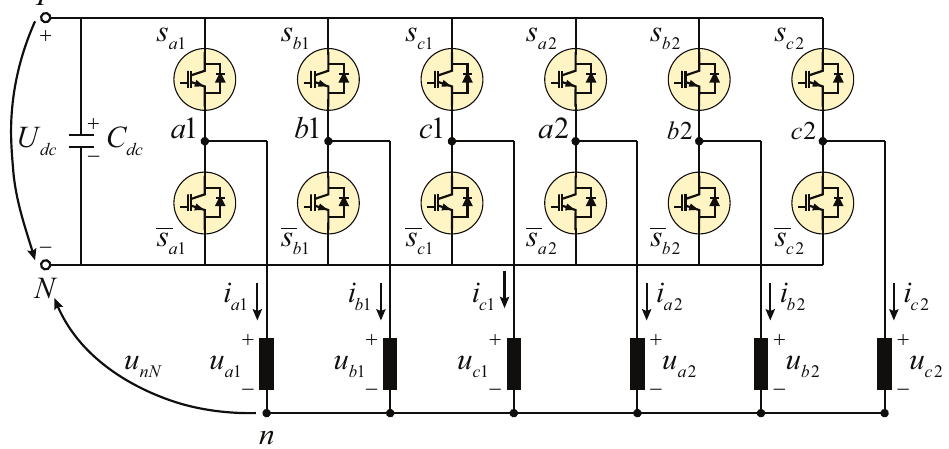
Figure 1. Diagram of a six-phase PMSM drive with a 1N